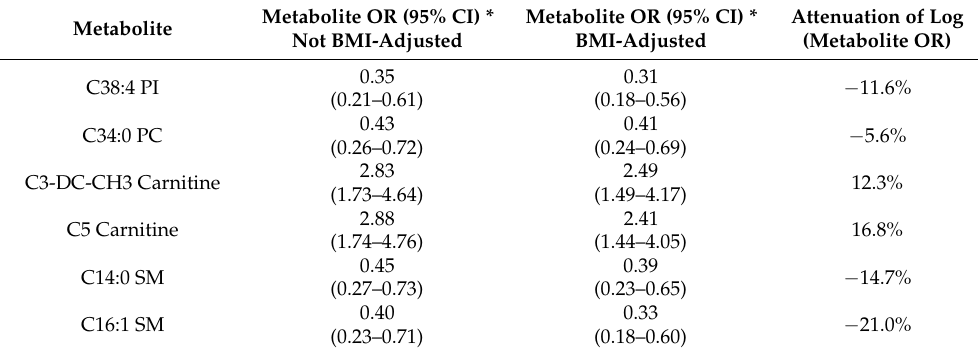
Table 5. Attenuation of the odds ratios for the metabolite–renal cell carcinoma association with the addition of BMI to the adjustment